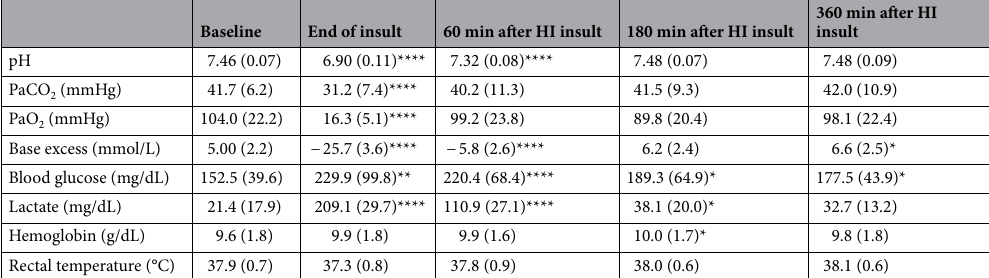
Table 1. Values of arterial gas and physiological parameters at baseline, at end of HI insult, and at 60 min, 180 min, and 360 min after insult. Values are shown as means (standard deviation). HI hypoxic–ischemic, pH arterial pH, PaCO 2 arterial PCO 2 , PaO 2 arterial PO 2 . * p < 0.05; ** p < 0.01; *** p < 0.001; **** p < 0.0001 versus baseline by one-way ANOVA, a post hoc analysis with Dunnett’s multiple comparison test. One piglet missed blood glucose and lactate data at 6 h after HI insult, two piglets missed rectal temperature baseline